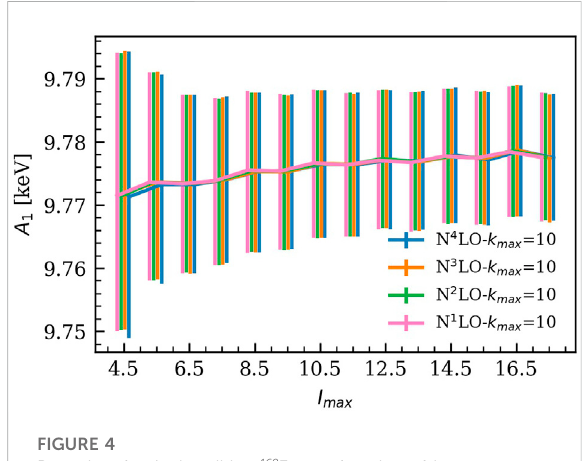
FIGURE 4 Posteriors for A 1 describing 169 Er as a function of I max at differentEFTorders.Thesolidlineconnectsthemedianvaluesand the error bands encompass the 16th and 84th percentiles of the marginalized